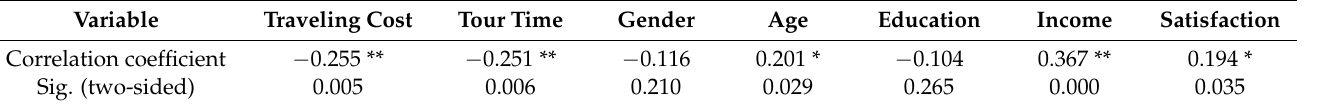
Table 5. Analysis of the correlation between the number of trips to Xiaochangshan Island and other